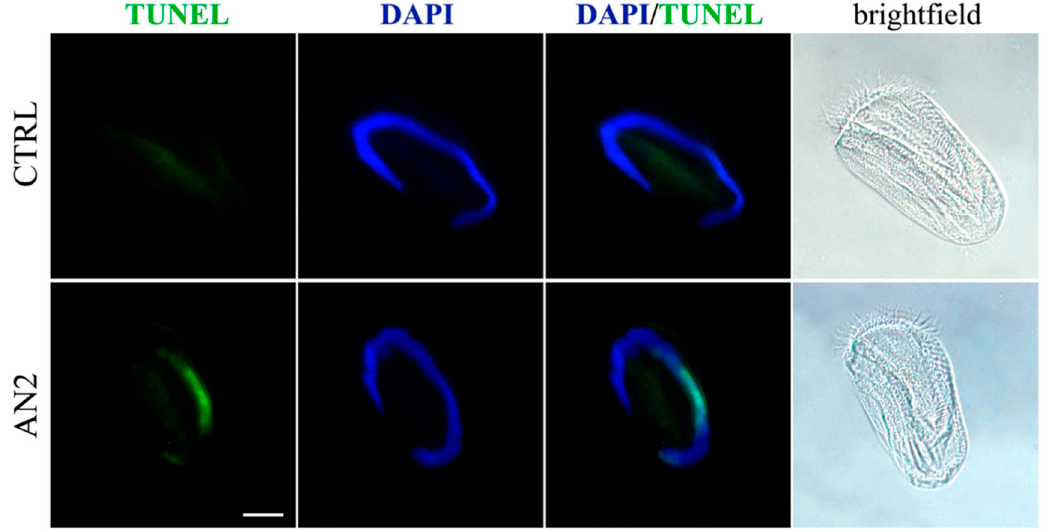
Figure 7. Induction of programmed cell death in ciliated protozoa Euplotes aediculatus . TUNEL assay in E. aediculatus treated with 2 µ g / mL AN2 or vehicle (CTRL) for 2 h. 4 (cid:48) ,6-diamidino-2-phenylindole (DAPI) (blue) was used for nuclei detection. Scale bar = 30 µ m. Original picture from [31] and